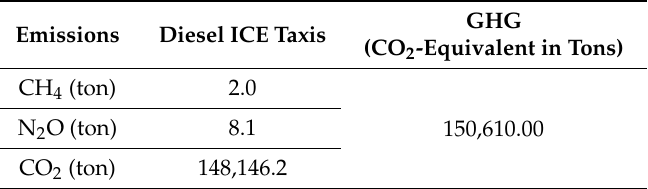
Table 3. Estimated GHG emissions by taxis in